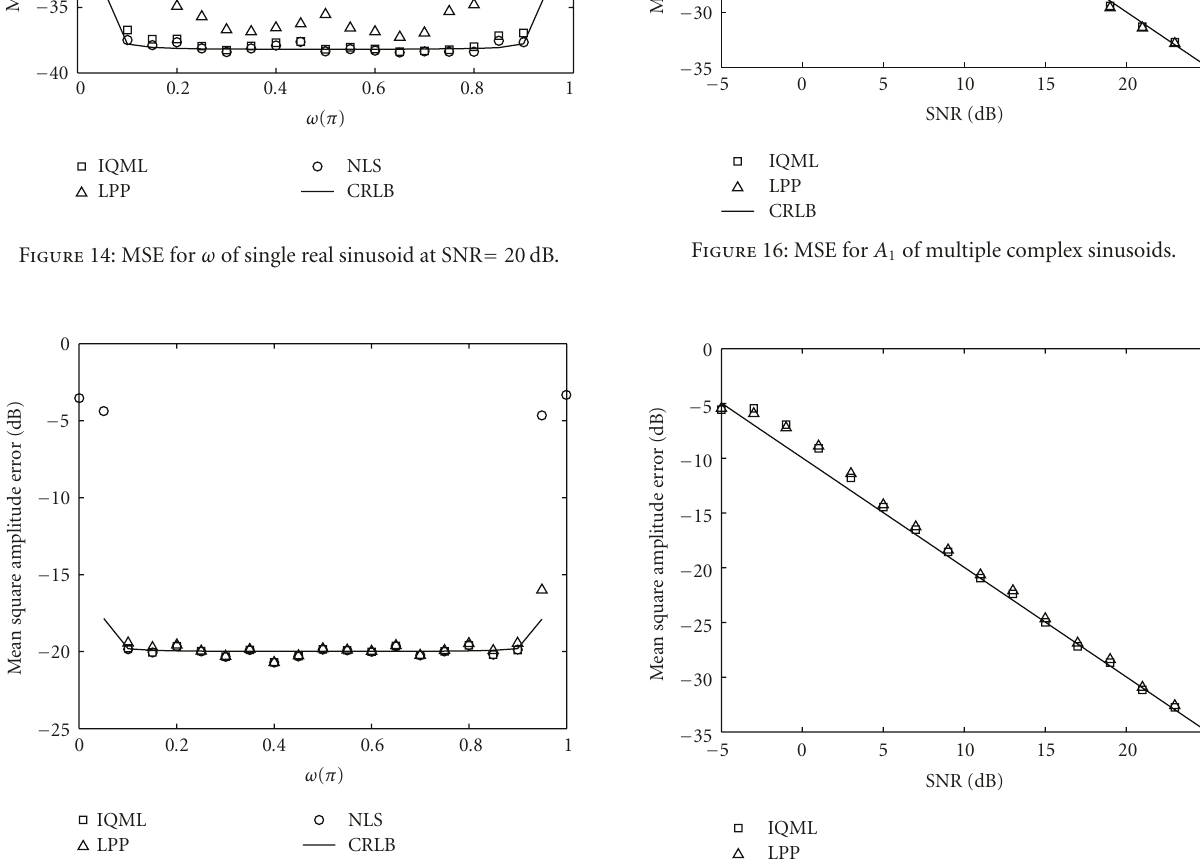
obtain di ff erent signal-to-noise ratio (SNR) conditions. All results are based on 500 independent